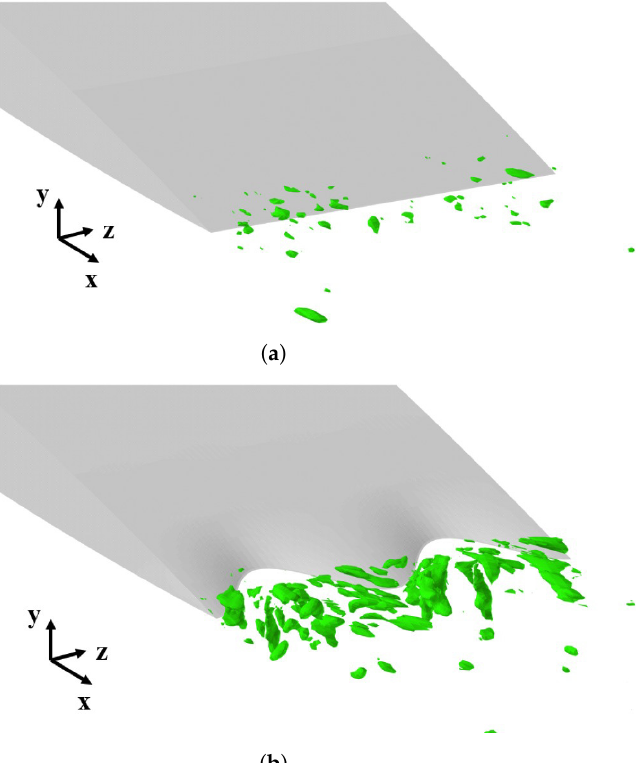
Figure 10. Iso-contours of Reynolds stress R 33 = 0.02 near the trailing edge: ( a ) NACA0012 airfoil; and ( b ) serrated